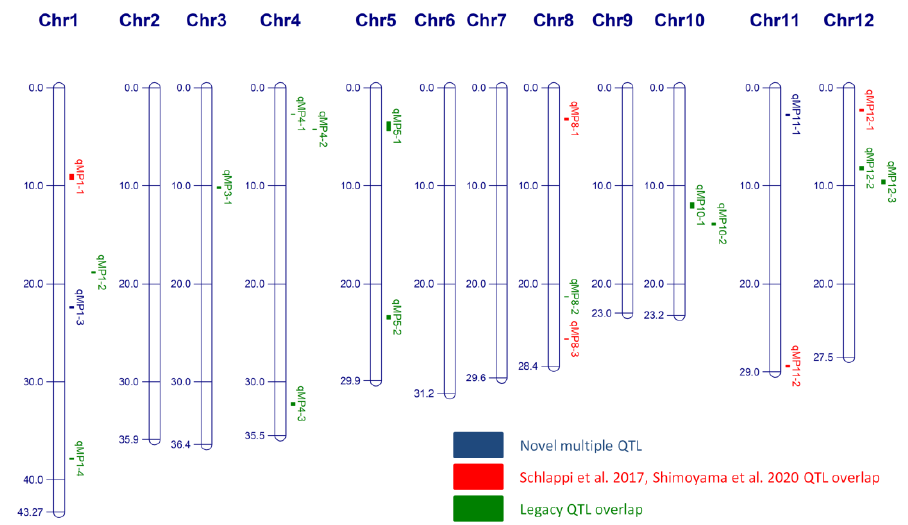
Figure 4. Genomic locations of 20 Multiple-Phenotype ( MP ) QTL. Numbers along the chromosomes (Chr) are million-base-pair (Mbp) units. Boxes show regions containing at least one antioxidant QTL ( qCAT ; qANT ) overlapping with another QTL ( qLTSS ; qEL ; qCAT ; or qANT ). Blue boxes show regions of novel cold stress tolerance QTL identified in this study; red boxes show regions of qMPs overlapping with cold stress tolerance QTL reported in Schläppi et al. 2017 [37] and Shimoyama et al. 2020 [40]; green boxes show qMPs overlapping with some legacy seedling stage cold stress tolerance QTL reported in the last five years (Lv et al. 2016 [46], and Wang et al. 2016 Table 2. Summary of 20 Multiple-Phenotype ( MP ) QTL identified by GWAS mapping for four phenotyping assays of 370 RDP1 O. sativa accessions after a 7-day-10 °C chilling treatment. LTSS: Low Temperature Seedling Survivability; EL: Elec- trolyte Leakage; CAT: Catalase Activity; ANT: Anthocyanin Activity; LOD: Logarithm of the Odds; SNP: Single Nucleo- tide Polymorphism. See Supplementary Table S3 for details on published QTL.